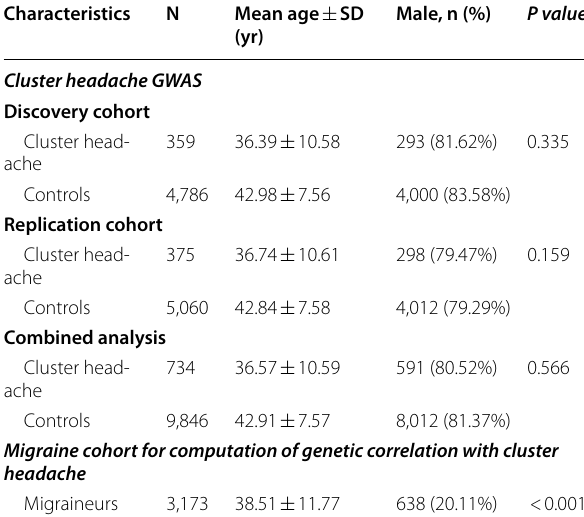
Table 1 Basic demographics of participants